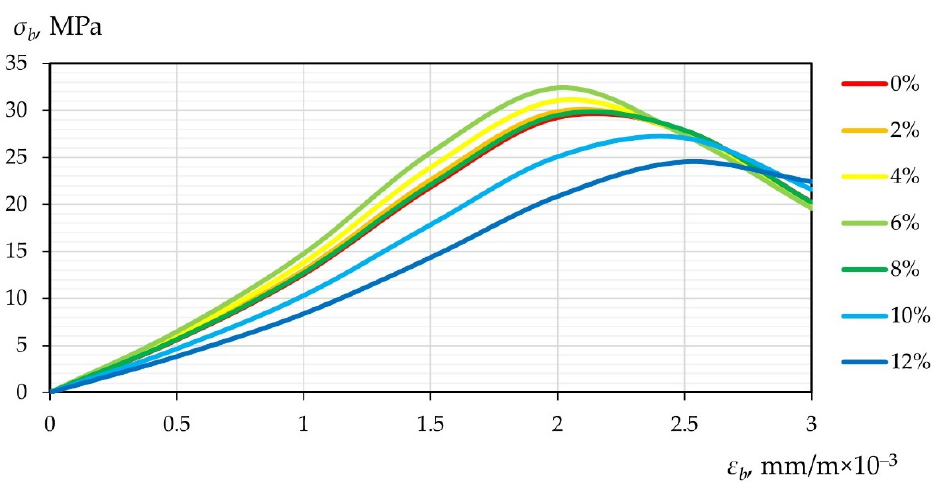
The influence of the dosage of snail shell powder on the deformation characteristics of concretes was also evaluated by plotting compression diagrams “ ε b − σ b ” and tension “ ε bt − σ bt ”. Stress–strain diagrams are shown in Figures 10 and 11.